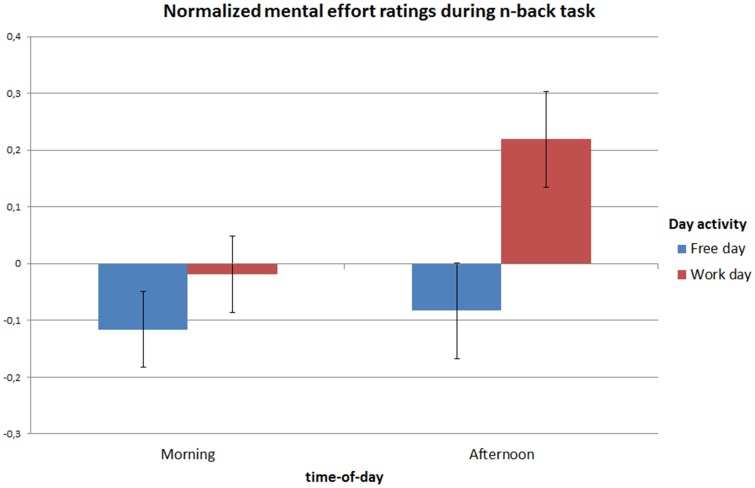
Effort ratings for all N-back conditions as an effect of treatment (work vs free days): Estimated marginal means per time-of-day and day activity (value of the centered covariate day order  = 0).Error bars represent standard errors.